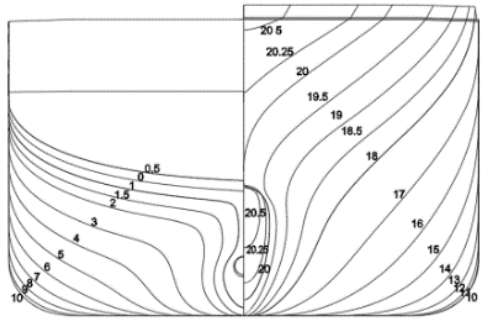
Figure 1. Body plan of the 13500 transmission extension unit (13500TEU) container ship. Table 1. Principal dimensions of the container Table 2. Model ship features at different drafts.